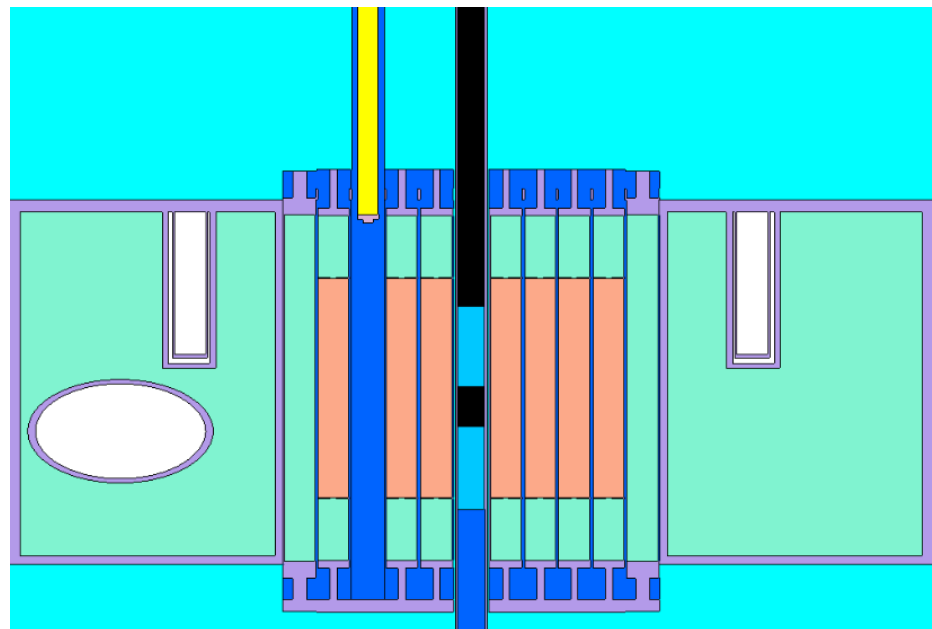
Figure 2: Vertical section of The TRIGA Mark II reactor model with water cylinders (light blue) inserted in the central channel (black), fuel rods (orange), control rod (yellow) and graphite reflector